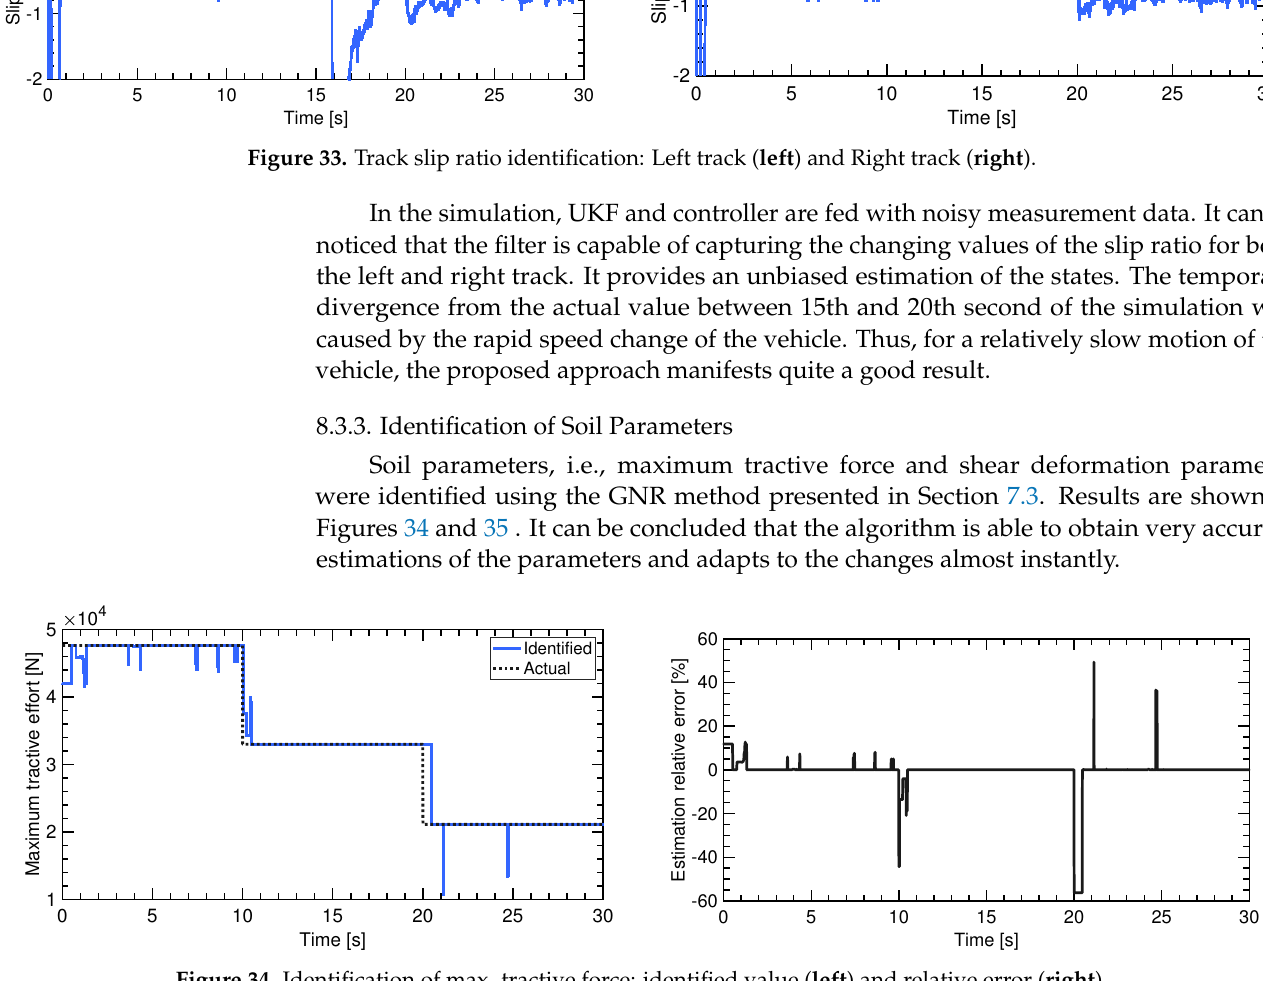
Figure 34. Identification of max. tractive force: identified value ( left ) and relative error ( right